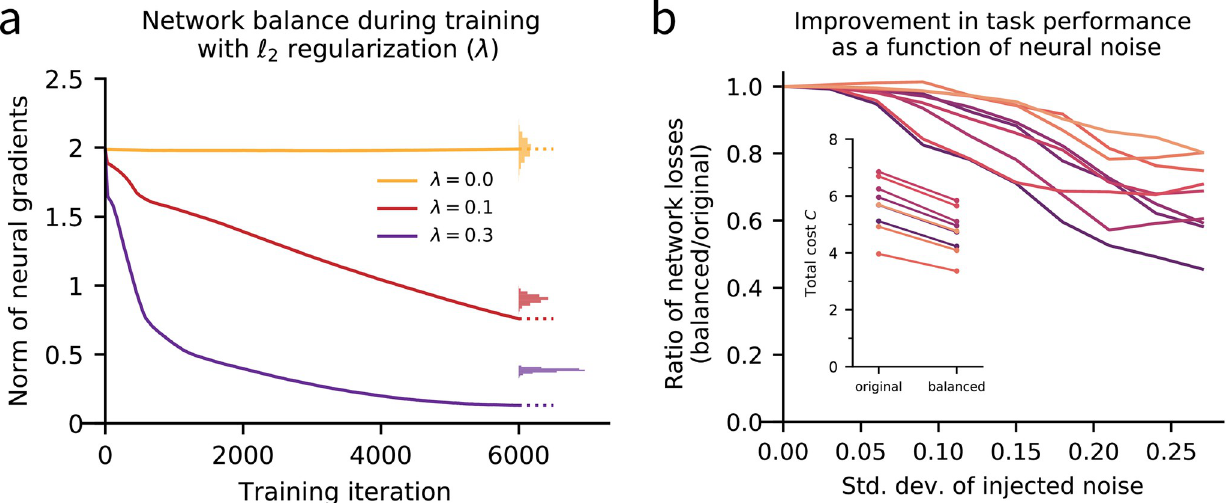
Fig 4. The balance condition in trained networks. (a) ReLu networks with N = 256 neurons are trained via gradient descent on a context-dependent integration (CDI) task modeled after [23], with varying levels of ℓ 2 penalty l When λ = 0, neural gradients are fixed by gradient descent dynamics. When λ > 0, trained solutions tend towards the balance condition (21), with c Histograms at right denote the empirical null distribution of k g k under permutation of the rows of C at the final training iteration. For positive values of λ , the actual value of k g k (dotted line) falls significantly below the null distribution. (b) Synaptic balancing with the robustness cost function (13) is applied to several ReLu networks trained with λ = 0.3 (corresponding to the purple curve in panel a ). The original and balanced networks are run on the CDI task at varying levels ε of Gaussian noise injected into hidden dynamics. For each network pair the ratio is plotted of task loss of the balanced network to that of the original network, as a function of ε . As dynamics become more noisy, the performance of the original networks (as measured by loss on the task) degrades faster than that of the corresponding balanced networks. Inset: total cost C of the original vs. balanced networks (12).